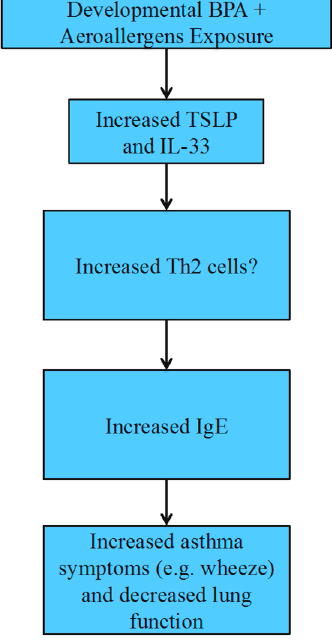
Figure 4. Asthma risk increases following developmental bisphenol A (BPA) and aeroallergen exposures in humans.